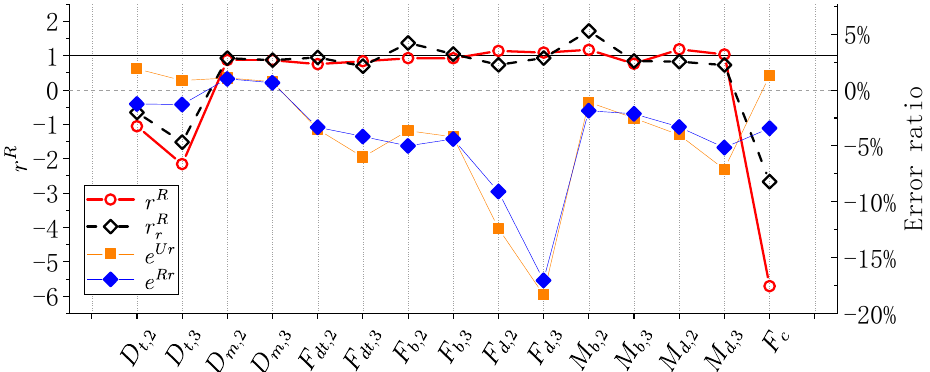
Figure 16. Comparison of the damping truncation error for MSE problem and its corresponding uniform excitation problem.